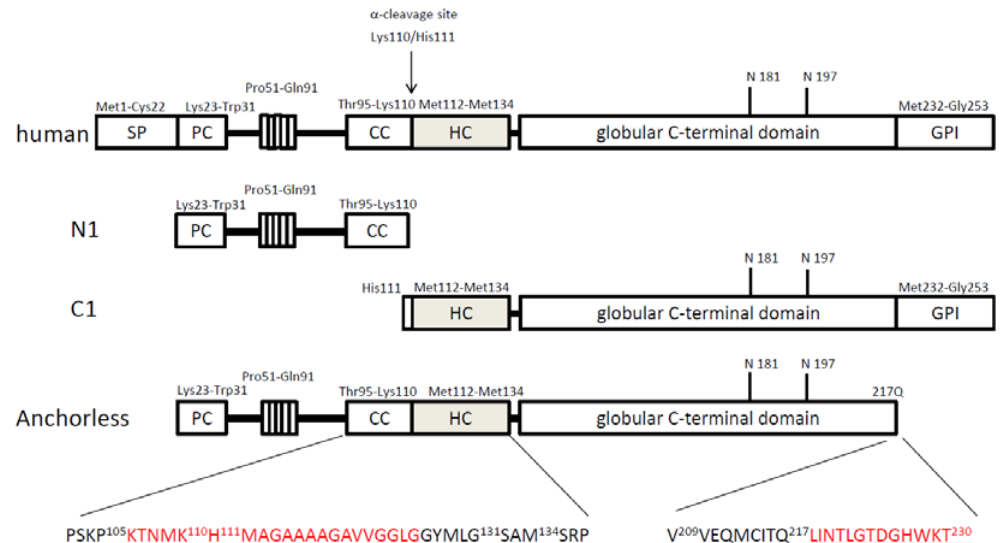
Figure 1. Diagrammatic representation of protein structure of normal cellular prion proteins. Based on the knowledge of physiological processing of prion protein (PrP C ), it is likely that mature PrP C (residues from 23 to 253), N-terminal (N1) (23 to 110), C-terminal (C1) (111 to 253), and anchorless PrP (23 to 230) may exist in normal brains of humans. Anchorless PrP seems to be unglycosylated and non-cleavable at putative  -cleavage site. The minimum sequence that causes spontaneous neurodegeneration when deleted in mice is shown in red. The additional open leading frame for anchorless PrP is underlined. SP, signal peptide; PC, positively charged region; CC, charged cluster region; HC, hydrophobic core